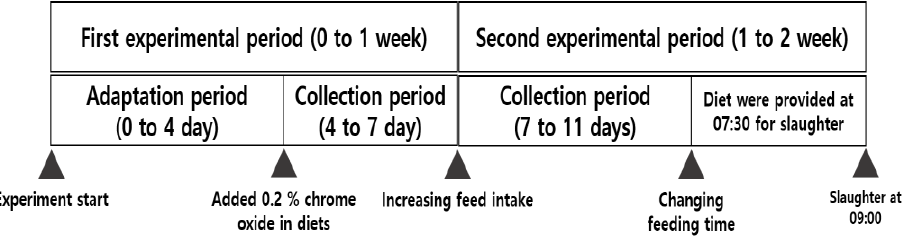
Figure 1. Schematic diagram of experimental design.